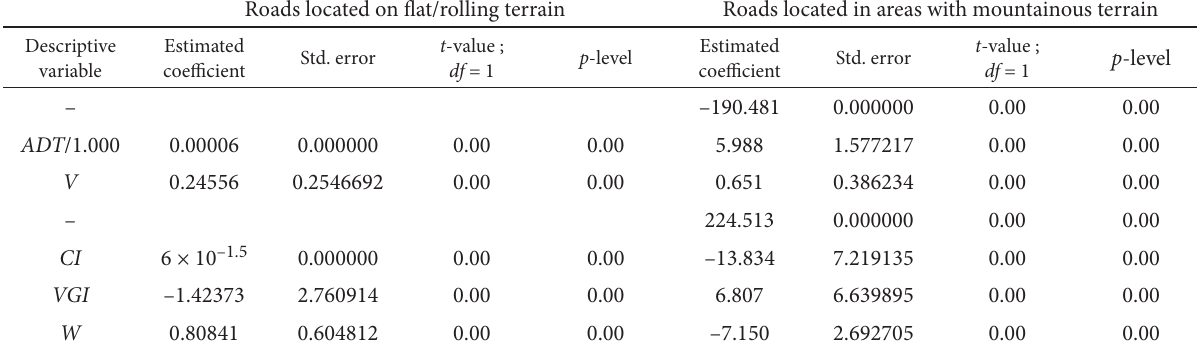
Table 4 . Coefficient of the variables in CPMs 1 and 2 Roads located on flat/rolling terrain Roads located in areas with mountainous